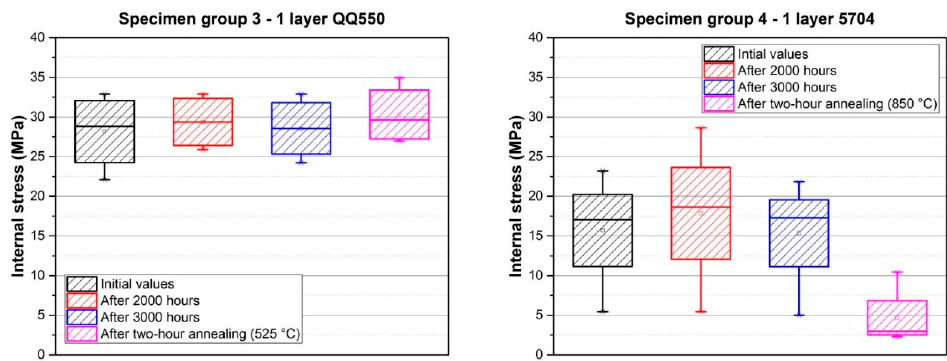
Figure 12. Internal stress changes over time for silver films—specimen group 5 ( left ), and specimen group 6 ( right ). Figure 11. Internal stress changes over time for dielectric films—specimen group 3 ( left ), and specimen group 4 ( right ).